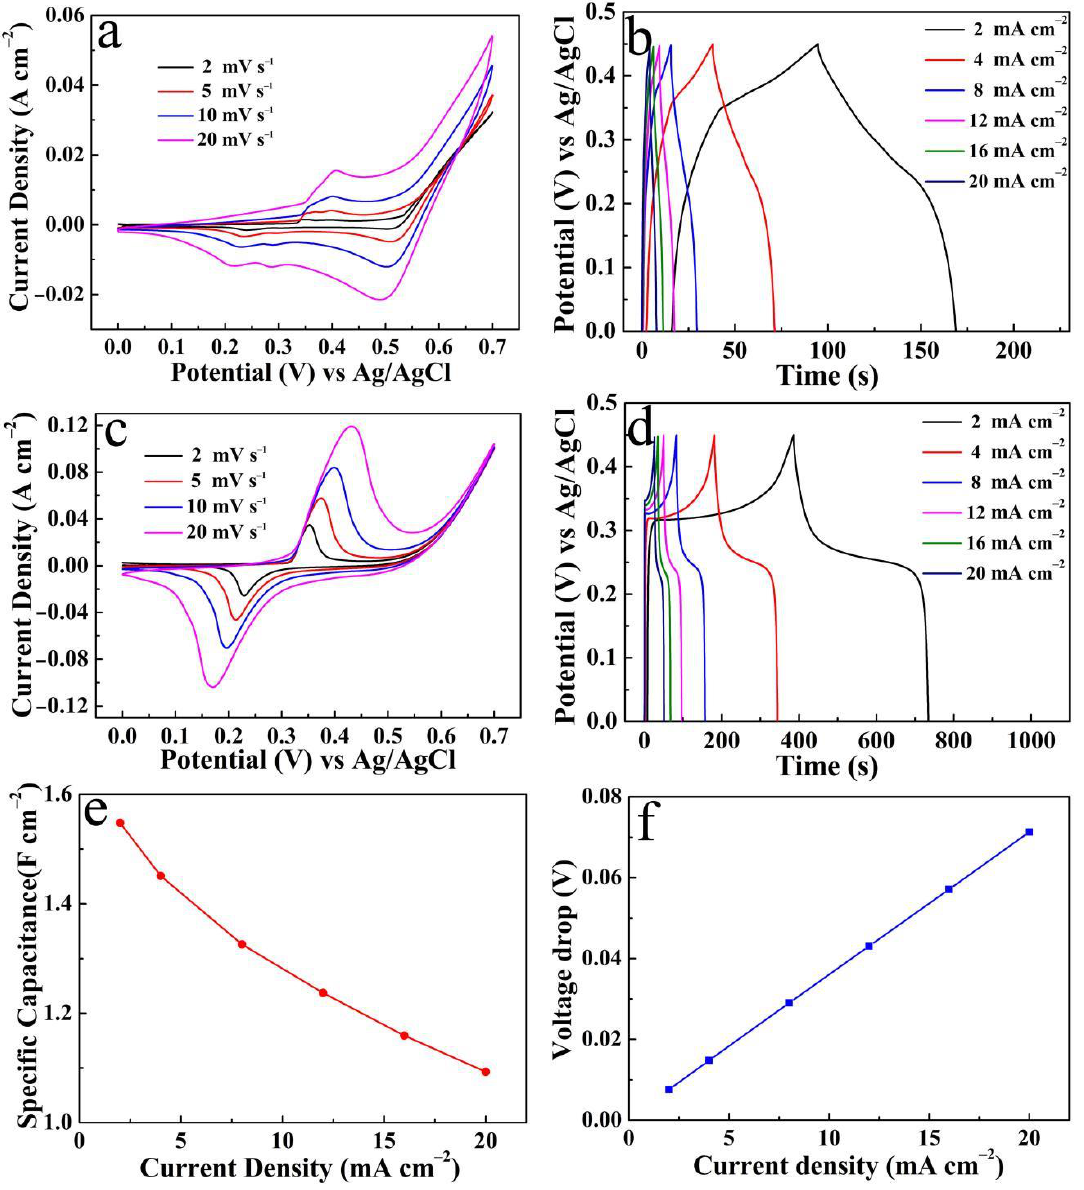
Figure 10. ( a ) CV curves and ( b ) GCD curves of Cu(OH) 2 , ( c ) CV curves, ( d ) GCD curves, ( e ) specific capacitances, and ( f ) voltage drops at different current densities of Ni 3 S 2 . Table 1. Comparison of specific capacitance of Cu(OH) 2 /Ni 3 S 2 with similar